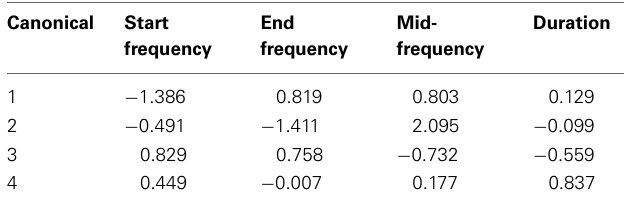
Table 2 | Standardized coefficients for the discriminant function analysis.